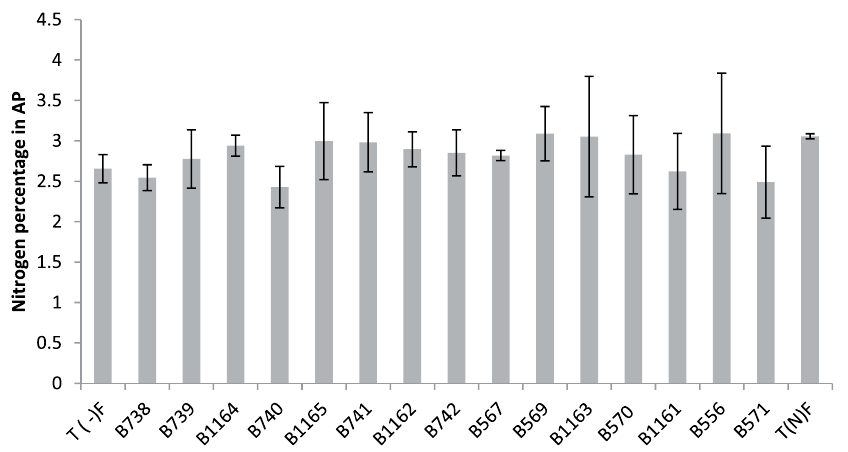
Fig. 3. Nitrogen percentage in the aerial parts of plants fertilized, non-fertilized and inoculated with different strains of Rhizobium obtained from nodules isolated from the city of Fez and its regions. All data represent the mean ± SD of three